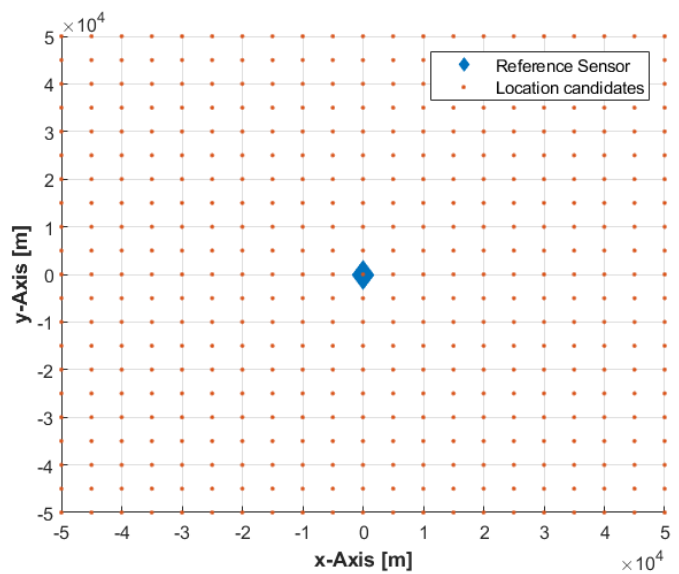
Figure 2. The solution space is approximated by a grid of emitter location candidates corresponding to the reference sensor coverage.